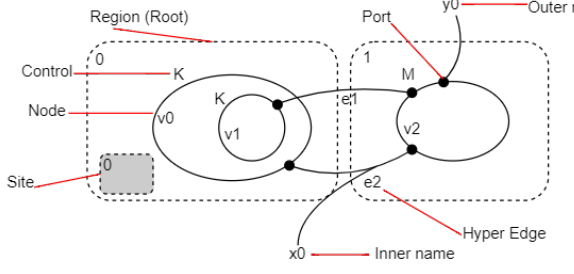
Figure 4. A bigraph